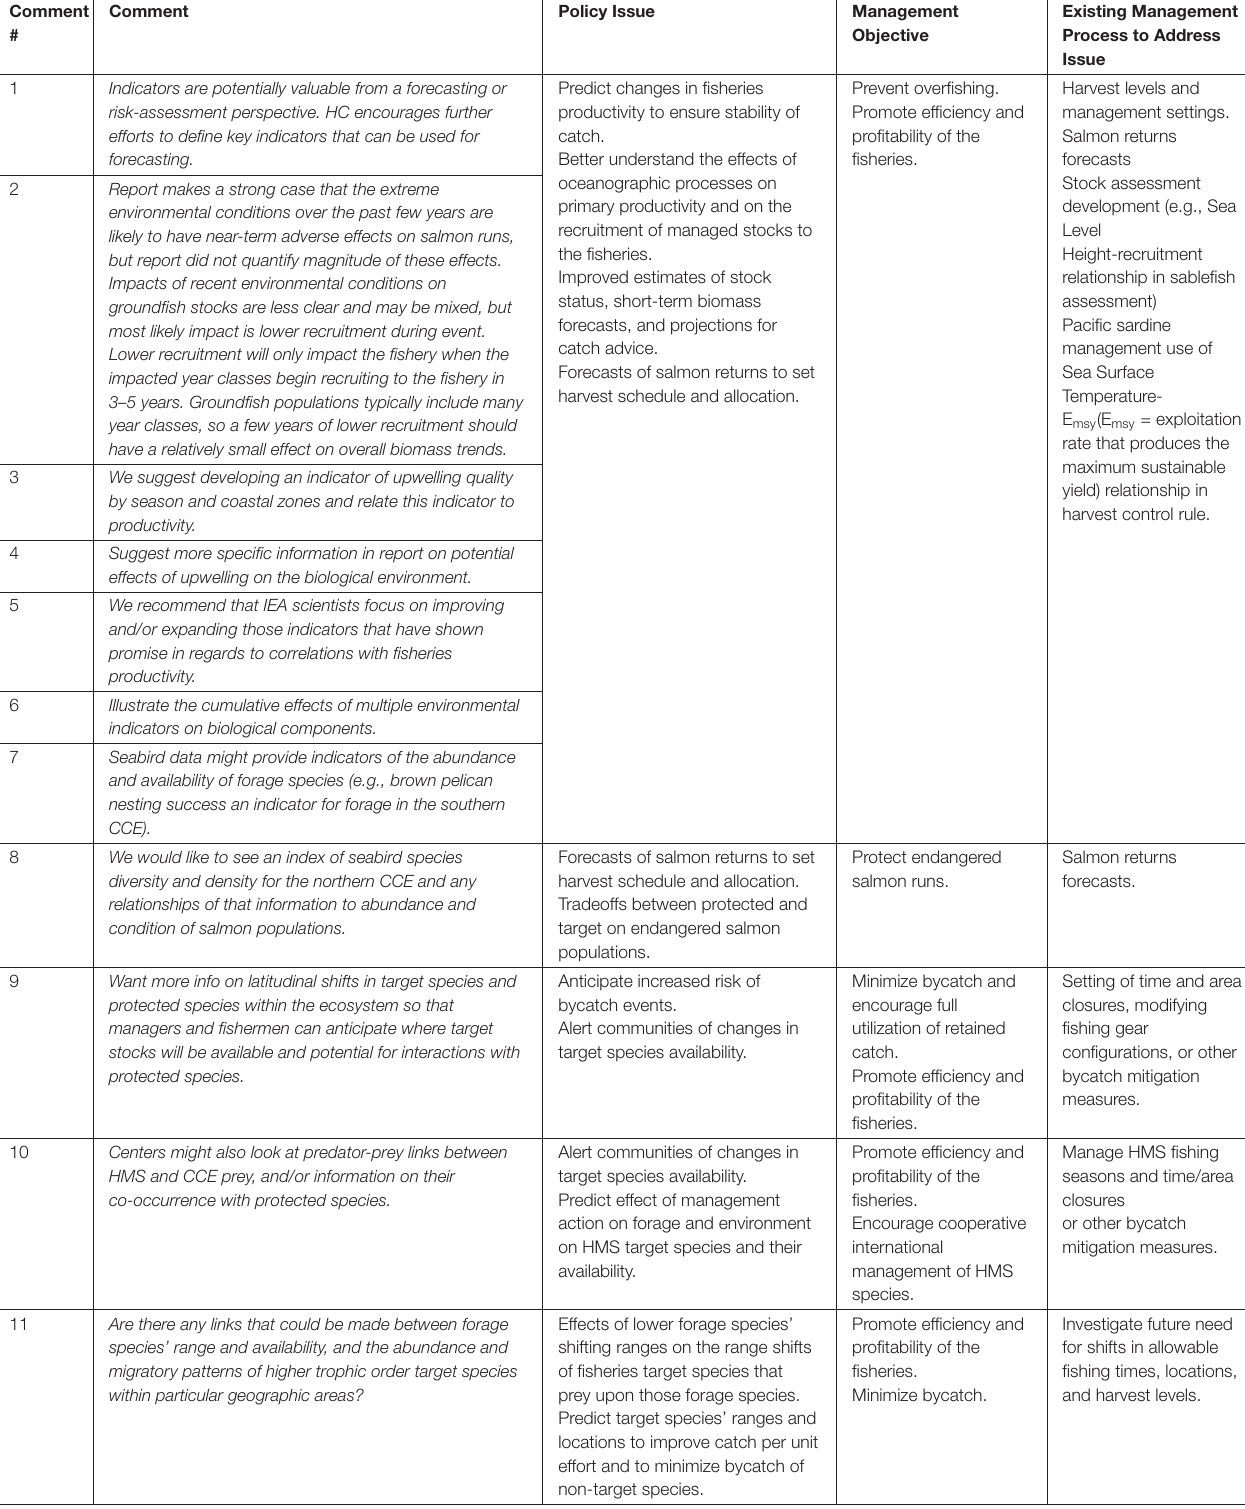
TABLE 1 | Comments from the stakeholder review of ESR Indicators that could be informed by ecosystem models and analyses with relevant policy issues, management objectives, and existing management processes to address